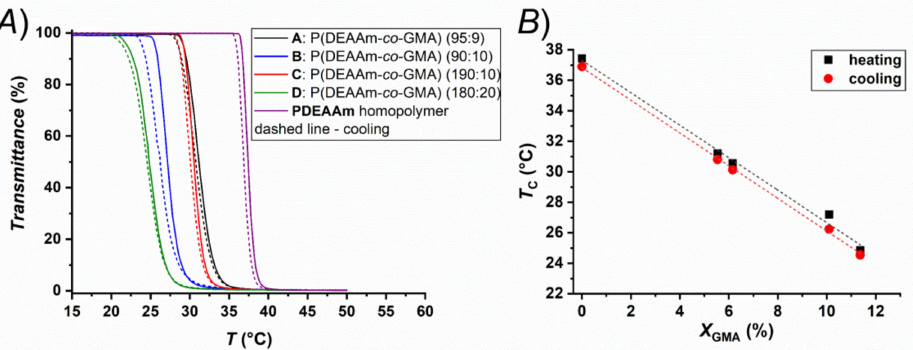
Figure 3. Transmittance vs. temperature curves of the P(DEAAm- co -GMA) copolymers and the PDEAAm homopolymer during heating and cooling ( A ) and the cloud points and clearing points as a function of the DEAAm content ( B